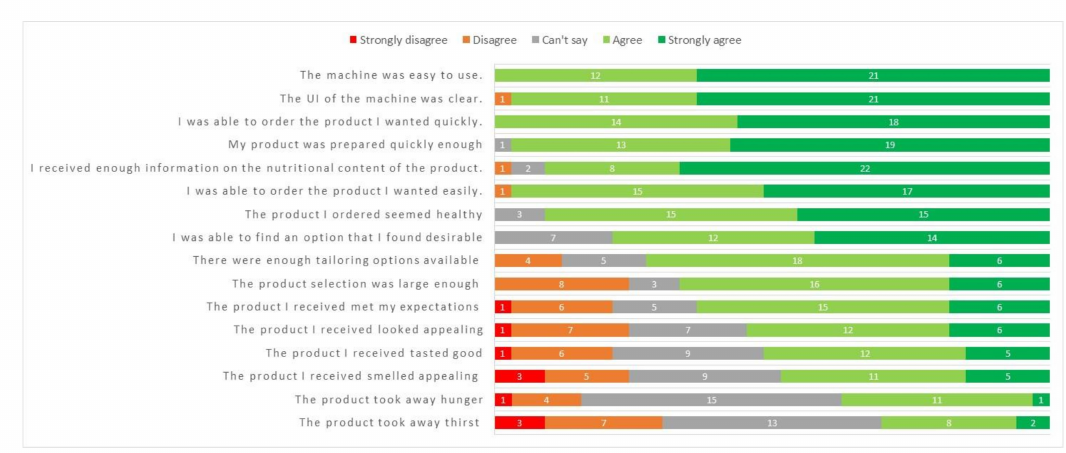
Figure 5. Questionnaire answers by consumers ( N = 33) in the qualitative consumer survey of Healthy Snack Machine